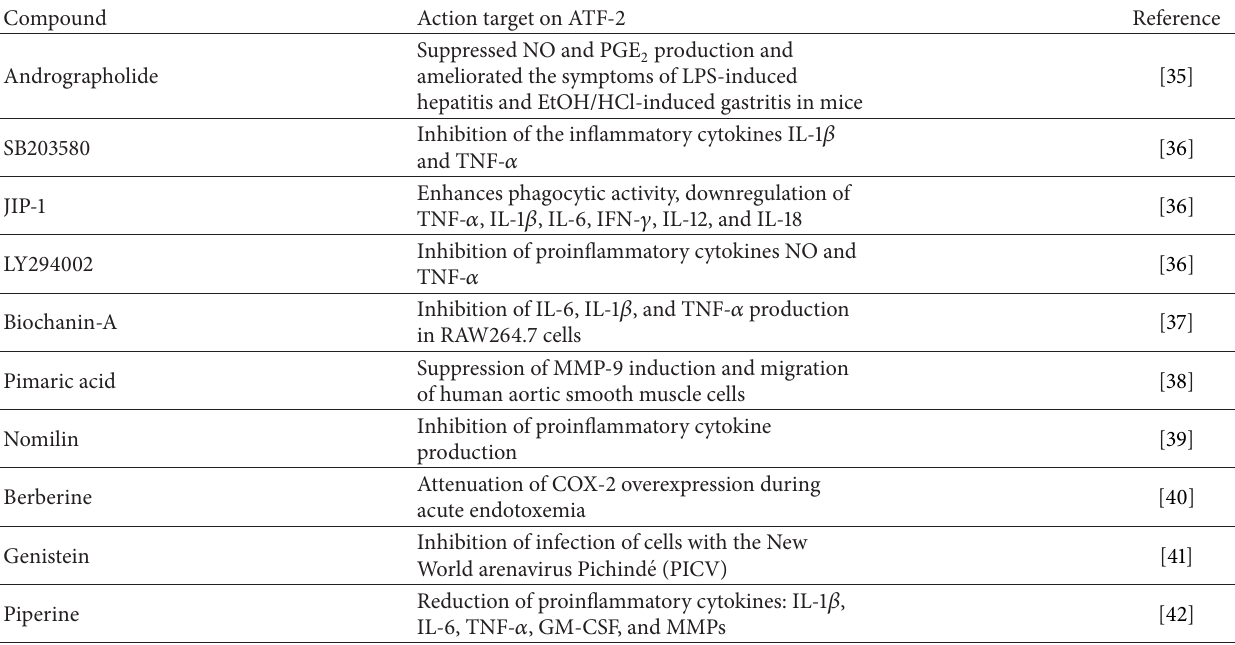
Table 2: Natural products which inhibit ATF-2 signaling pathway.